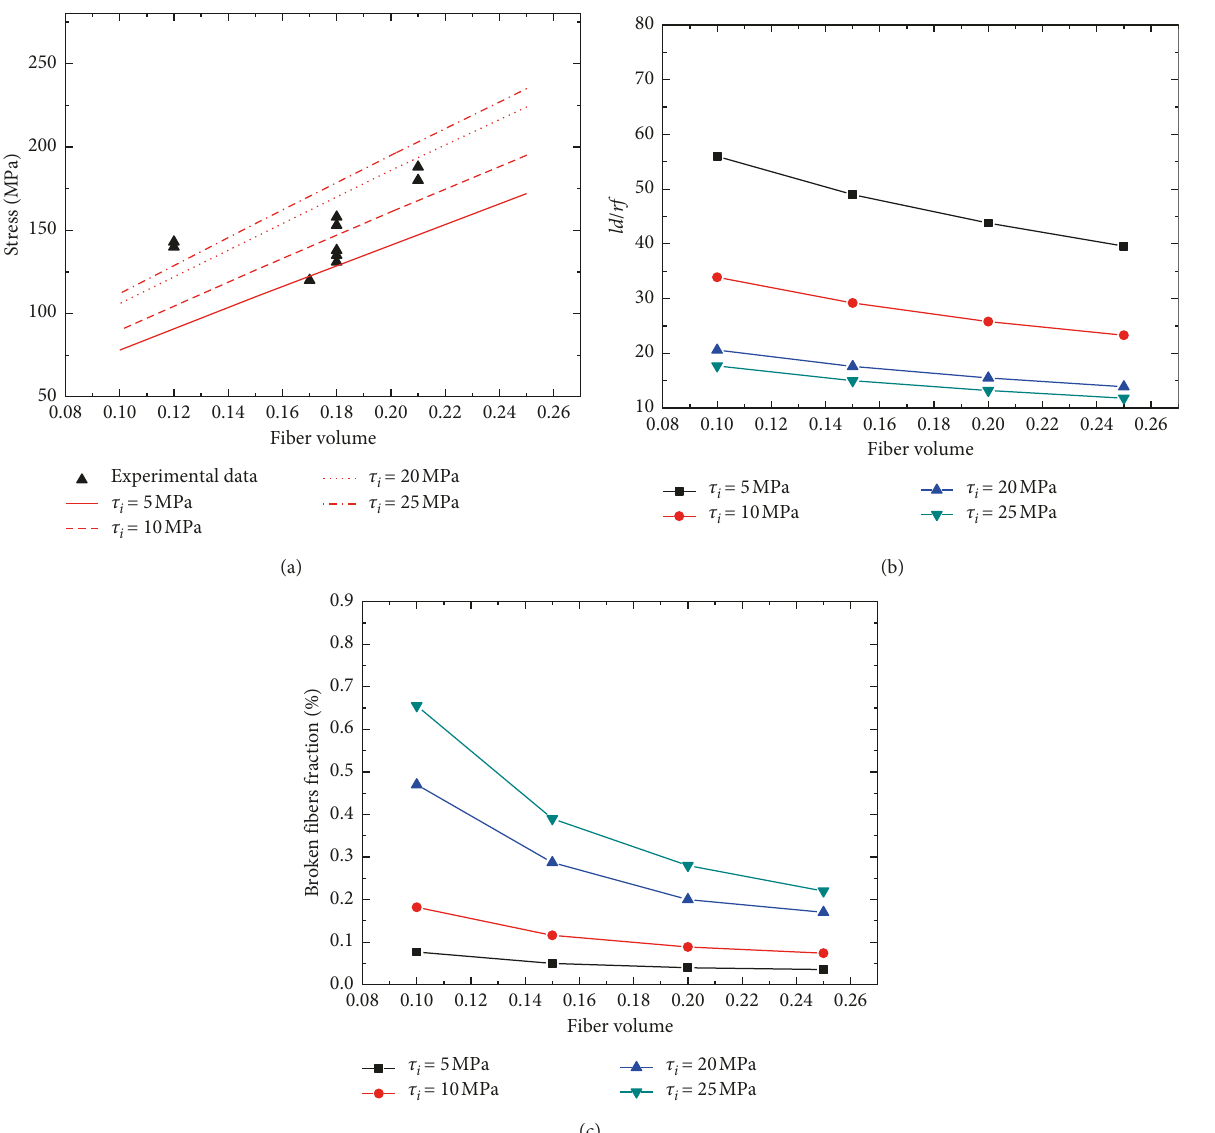
Figure 8: (a) The experimental and predicted first matrix cracking stress versus the fiber volume curves; (b) the interface debonding length versus the fiber volume curves; (c) the broken fibers fraction versus the fiber volume curves of 2D Sylramic ™ SiC/SiC